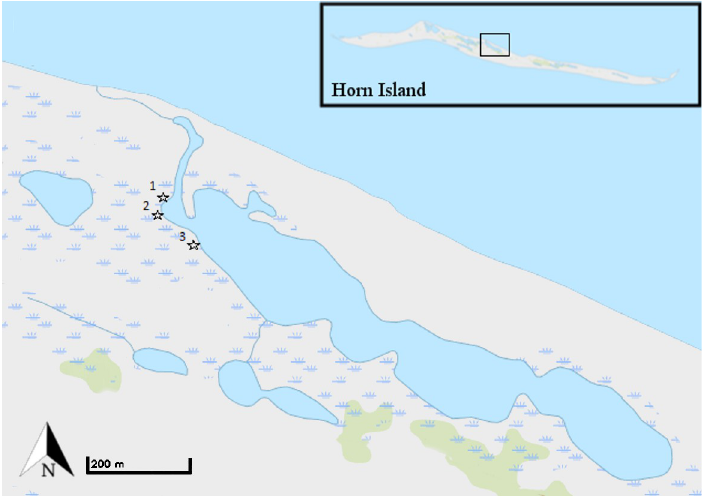
Fig 1. Map of stations 1–3 (stars) on Horn Island, MS. Study region indicated on inset of Horn Island in top right. Each station contained a mixed and reference plot, 5m apart. Mixed (2012–2013) and reference (2013) plot sizes were scaled to the size of the A . germinans tree in the corresponding station (Stations 1 and 3: 1.0m 2 ; Station 2: 0.25m 2 ). Imagery of the study site and the Horn Island insert were obtained from USGS National Map Viewer (public domain). second, marsh-only (“reference”), plot, 5m away from its paired mixed plot. S . alterniflora was the dominant species of marsh plant and referred to as “ S . alterniflora -mixed” in mixed plots and “ S . alterniflora -ref” in reference plots. Mixed and reference plot sizes were scaled to the